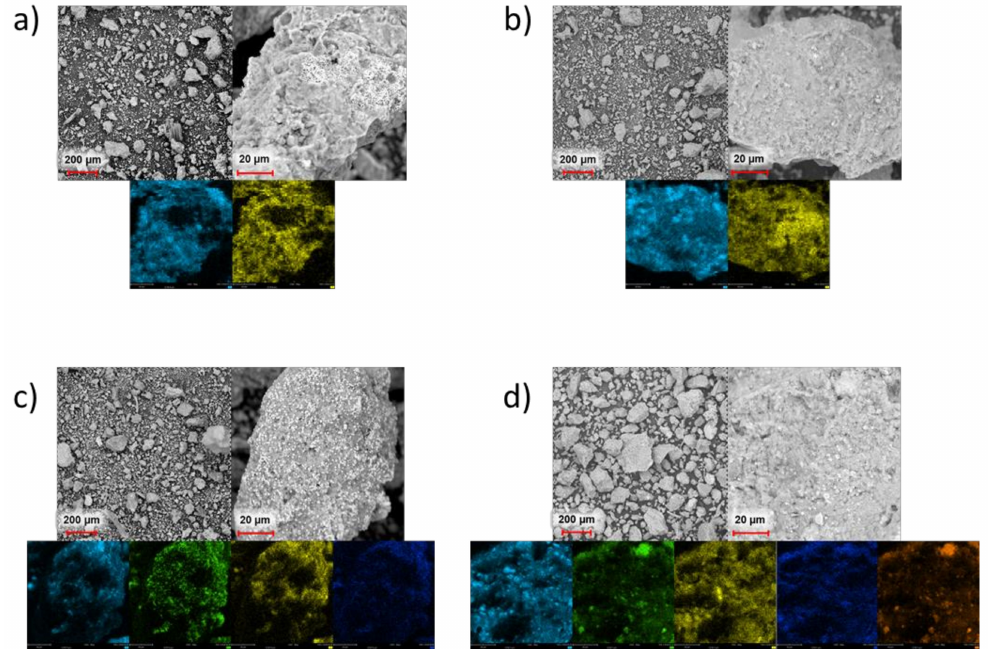
Figure 1. Scanning electron microscope (SEM) images and energy-dispersive X-ray (EDX) mapping of the ( a ) raw drill cuttings, ( b ) control drill cuttings, ( c ) supported drill cuttings, ( d ) supported drill cuttings after upgrading. Light blue—silicon, yellow—aluminum, green—molybdenum, dark blue—nickel,